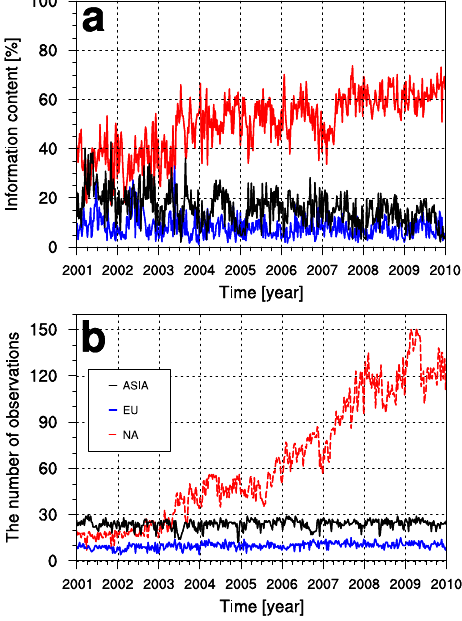
Figure 12. Times series of the (a) weekly averaged information content and (b) number of observations in Asia (black line), Europe (blue line), and North America (red line) from 2001 to 2009.